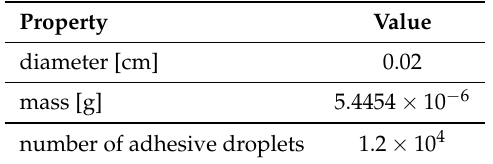
Table 5. Properties of adhesive droplets for scenario